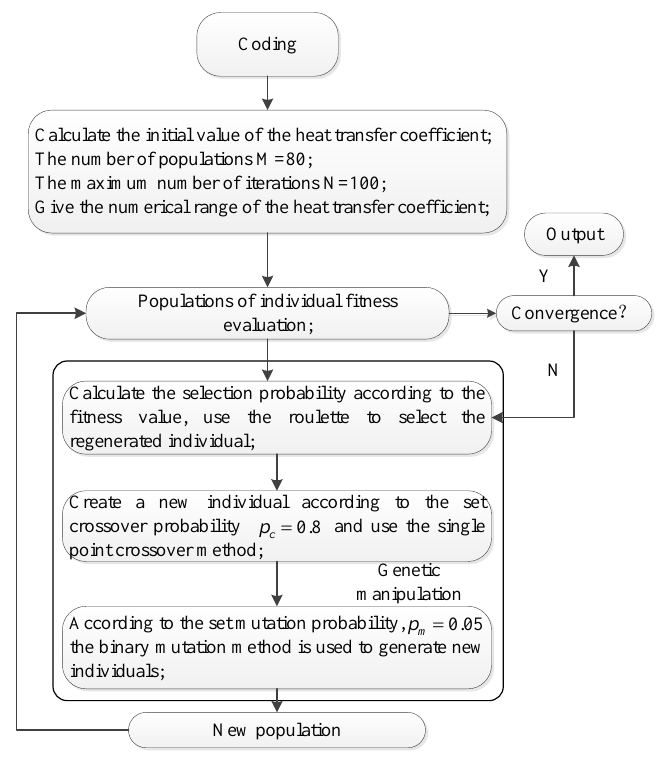
Figure 3. Flowchart of genetic algorithm.